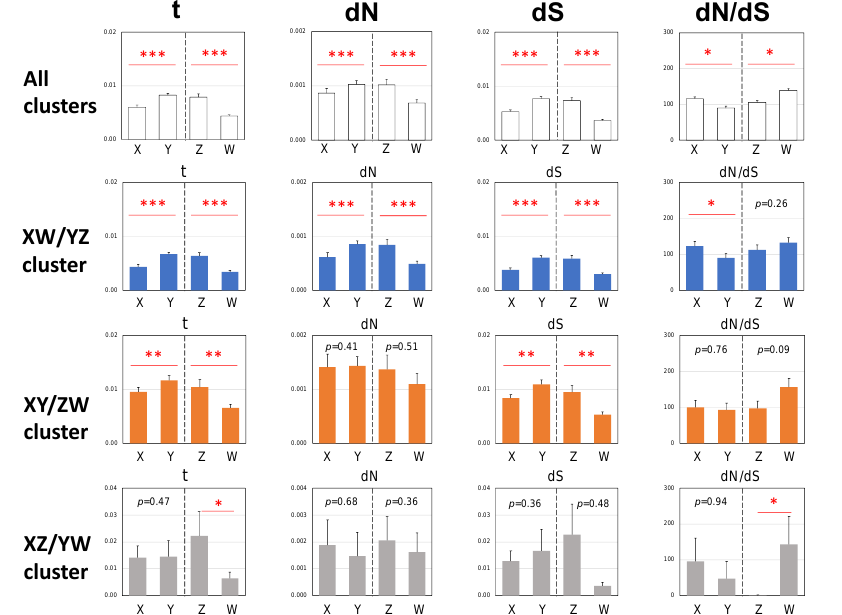
Figure 3. Sequence identities of the sex-linked genes between the sex chromosomes X and Y, and Z and W, located at the regions from 0 to 160 M and 160 to 184 M, respectively. ( A ) All the three clusters. ( B ) XW/YZ cluster. ( C ) XY/ZW cluster. ( D ) XZ/YW cluster. The statistical analysis was performed using Tukey HSD: *, **, and *** indicate p < 0.05, p < 0.01, and p < 0.001, respectively. The numbers of genes used for the analysis are shown on the bars. The abbreviations are the same as in Figure 2.